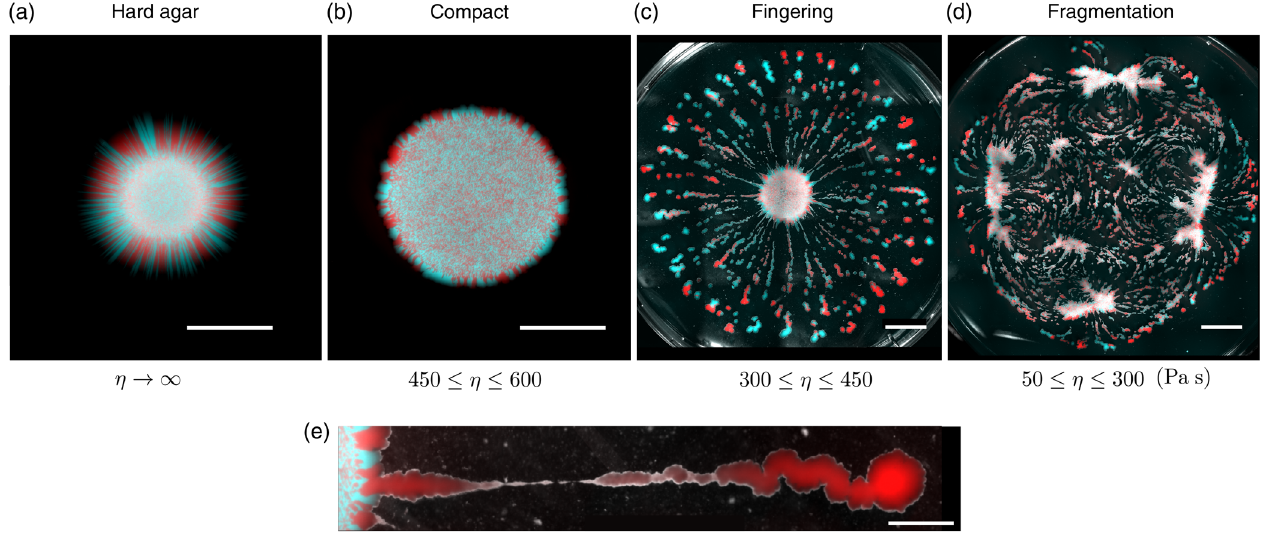
FIG. 1. Selected yeast colony morphologies on (a) a hard agar plate after 72 h of growth and on the surface of the viscous substrate with decreasing viscosities: (b) for η ¼ 600 (cid:2) 90 Pa s after 72 h of growth, (c) η ¼ 450 (cid:2) 70 Pa s after 84 h of growth, (d) η ¼ 300 (cid:2) 45 Pa s after 36 h of growth, and (e) magnification of a single representative finger from regime (c). Qualitatively similar morphologies are observed in the range of viscosities indicated in (b) – (d). The figure shows merged bright-field and fluorescent images White, transmitted bright field; red, YFP strains; cyan, mCherry strains. The scale bars in (a) and b) correspond to 5 mm, the scale bars in (c) and (d) to 10 mm, and to 2 mm in